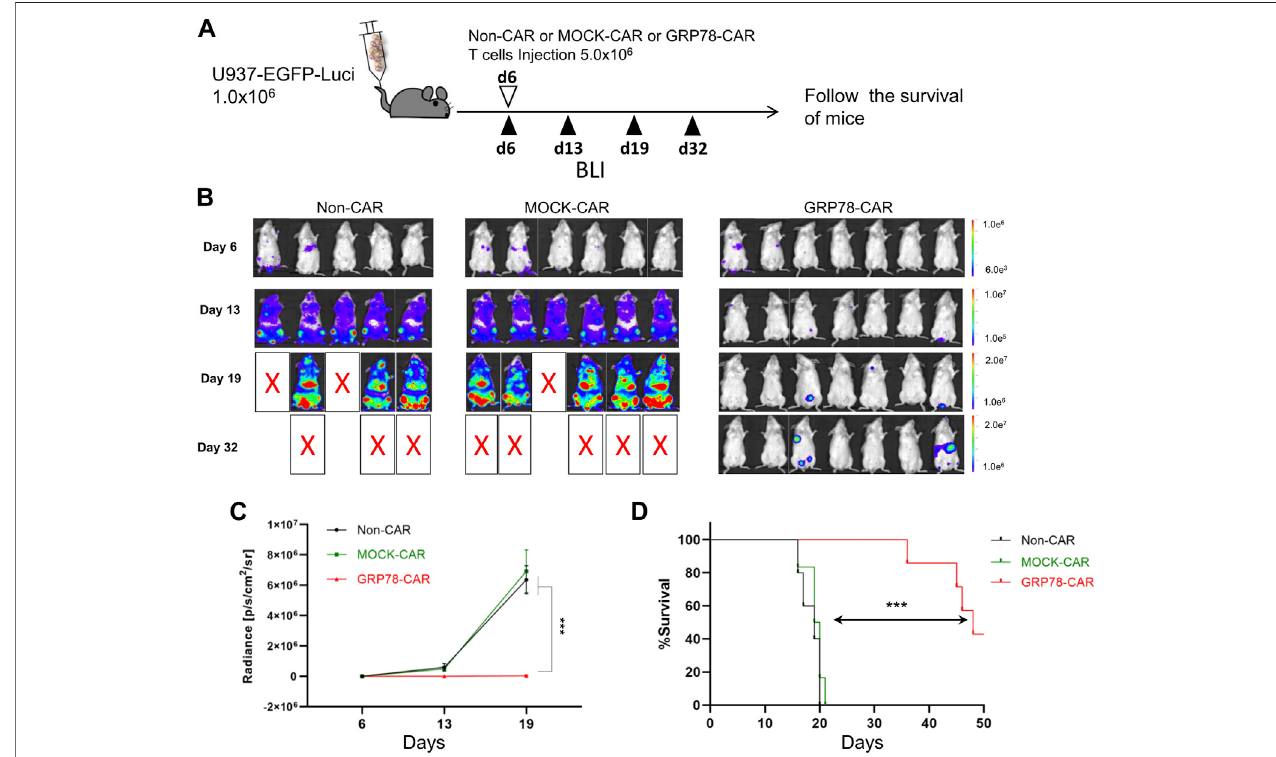
FIGURE 2 | Glucose-regulated protein 78 (GRP78) – chimeric antigen receptor (CAR) T cells eliminate human acute myeloid leukemia (AML) in vivo in xenograft mouse models. (A) Schematic ofthe U937leukemia cellxenograftmodel. NSG mice wereinjected via the tailvein with1×10 6 U937-EGFPluciferase (U937-EGFP-Luc) on day 0. Bioluminescent imaging (BLI) was performed on day 6 to quantify engraftment and for randomization of treatment groups. GRP78-CAR T cells (5 × 10 6 ), MOCK-CAR T cells (5 × 10 6 ), or Non-CAR T cells (5 × 10 6 ) were injected via the tail vein on day 6, followed with serial BLI. BLI radiance was measured as a surrogate quanti fi cation of tumor burden. (B) tumor burden was visualized by BLI on days 6, 13, and 19 following U937-EGFP-Luc cell transplantation. (C) bioluminescentsignalforeachtreatmentgroupovertime.Datarepresentmeanvaluesofeachgroup±SEMs.Thenumberofmiceineachgroupislistedin (B) .Two-way ANOVA test was performed between GRP78-CAR T-cell treatment and Non-CAR and MOCK-CAR T cells. *** p < 0.01. (D) Kaplan – Meier analysis of survival. Log-rank (Mantel – Cox) tests were used to perform statistical analyses of survival between groups.